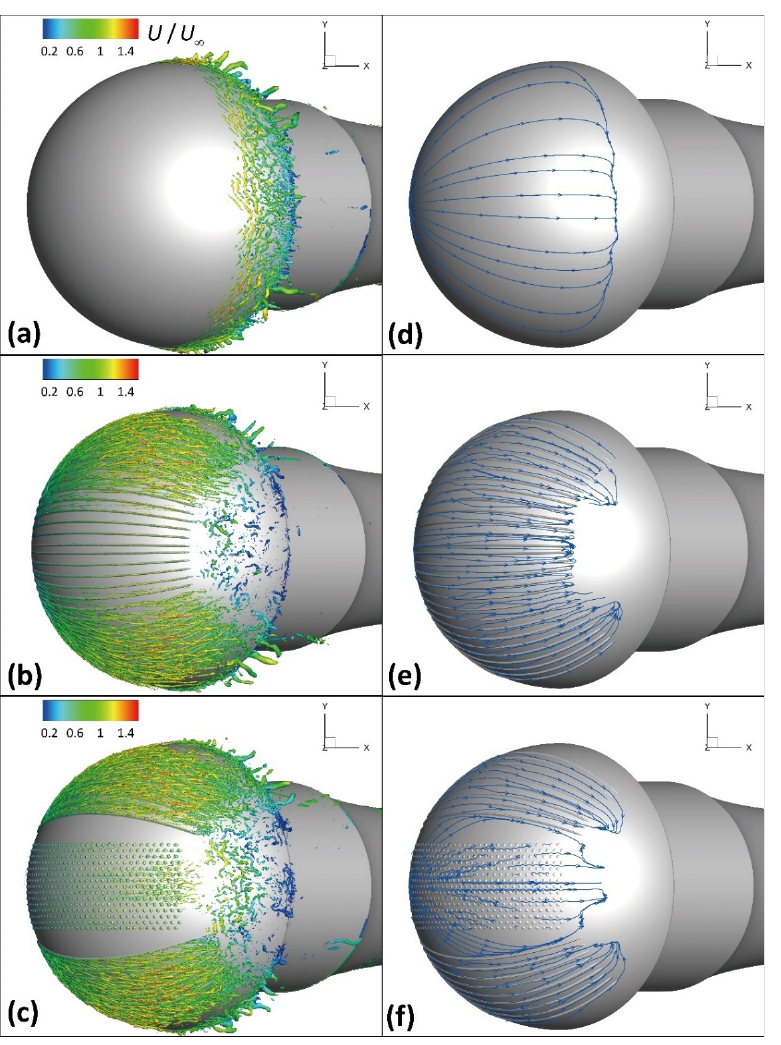
Figure 15. The vortex iso-surface based on the Q criterion at (Q = 10,000) of CFD helmet models: ( a ) original model, ( b ) riblet model, ( c ) bumped model; ( d – f ) surface streamline on the original and structured models.